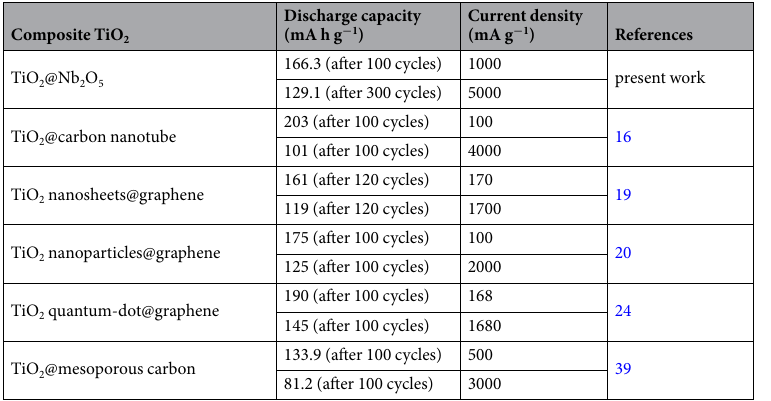
Table 1. Comparison of the cycling performance of TiO 2 @Nb 2 O 5 with some representative TiO 2 @ carbonaceous materials as an anode for